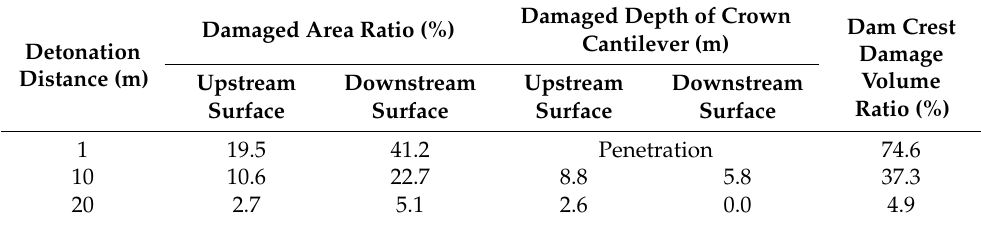
Table 4. Arch dam body damage at various blasting